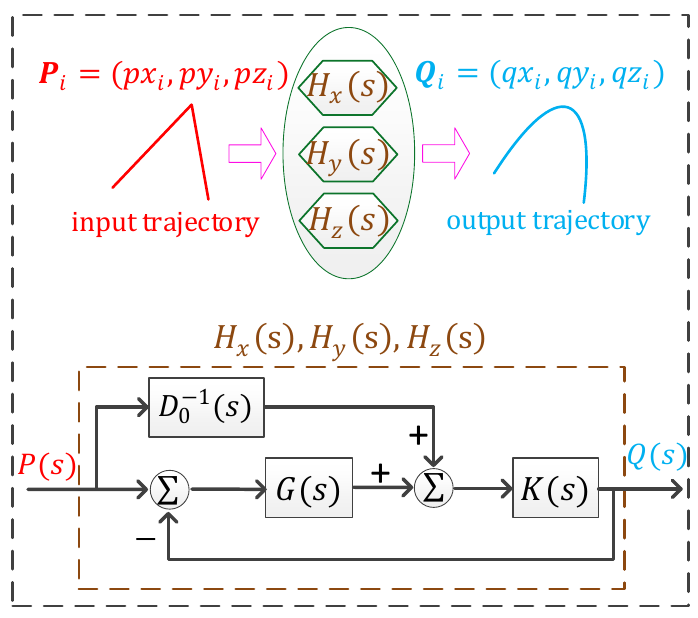
Figure 2. The function and control structure of the servo system. The solution of the coefficients and initial conditions of this difference equation will be detailed